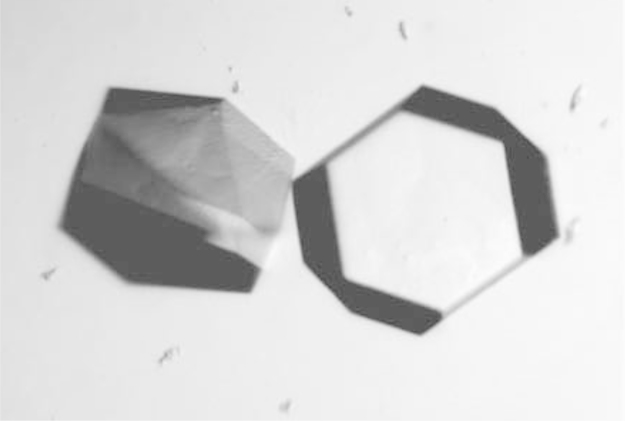
Crystals of wild type H-RAS with symmetry of space group P3221.